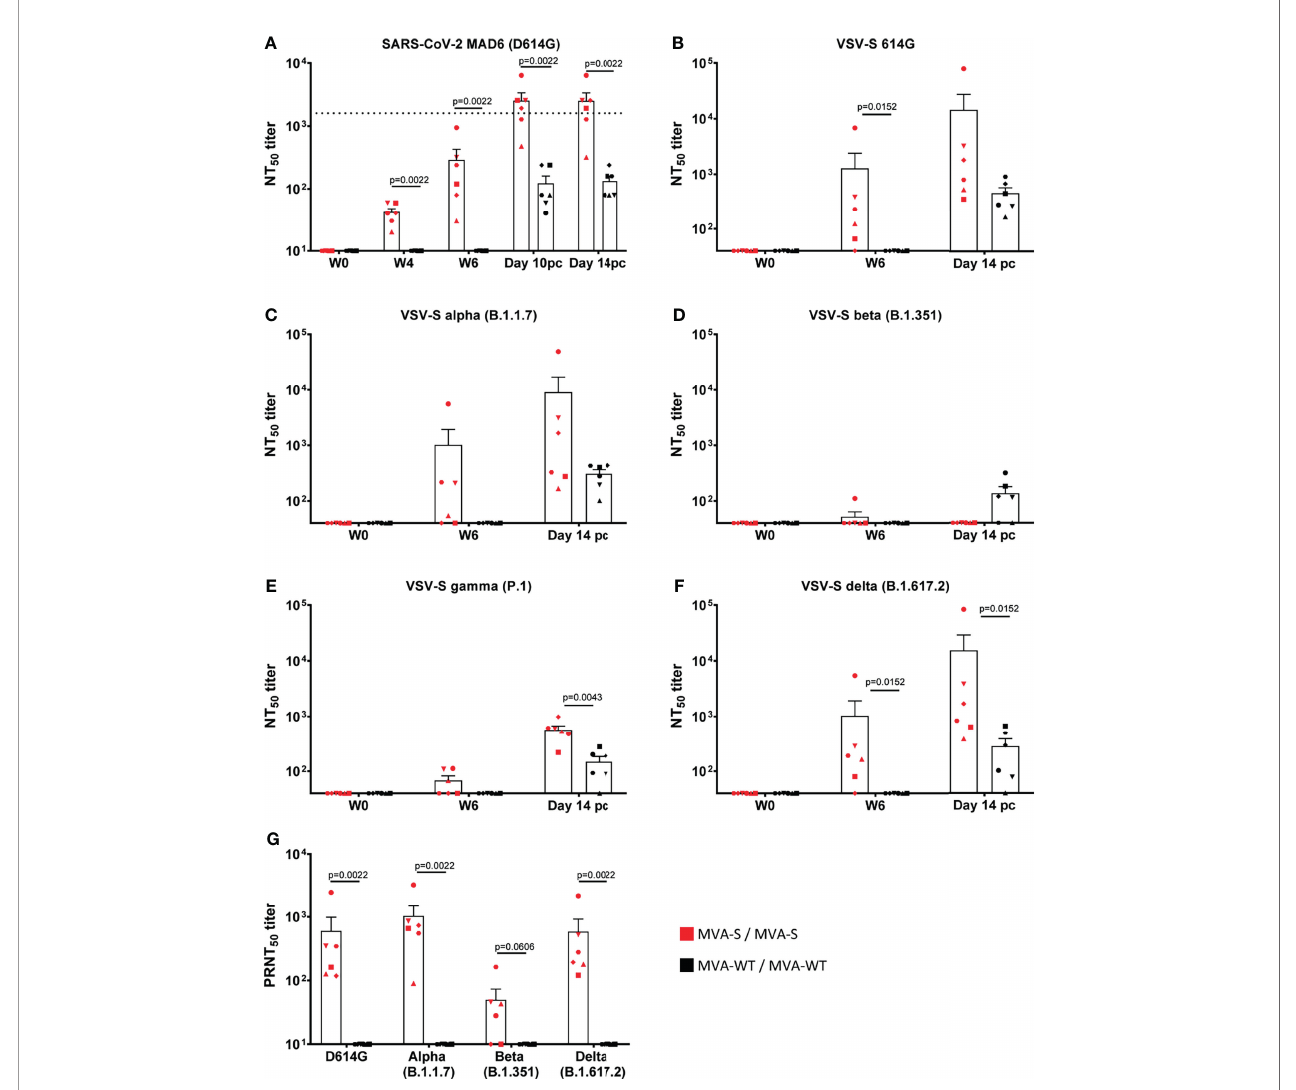
FIGURE 3 | MVA-S vaccination induced SARS-CoV-2 neutralizing antibodies. SARS-CoV-2 neutralizing NT 50 antibody titers to SARS-CoV-2 strain MAD6 (having the D614G mutation) (A) , VSV-luciferase recombinant viruses pseudotyped with SARS-CoV-2 Spike_614G (B) , alpha (C) , beta (D) , gamma (E), and delta (F) VOC at different timepoints, and live SARS-CoV-2 D614G and VOC alpha, beta, and delta (G) . Horizontal dotted line indicates level of neutralizing antibody titers measured in a human convalescent sera standard (NIBSC 20/136) (A) . Each animal is represented by a symbol. Mean and SEM are shown in columns for each group of animals. Signi fi cant differences between the groups are indicated in the graph by a horizontal line and p-value (Mann – Whitney